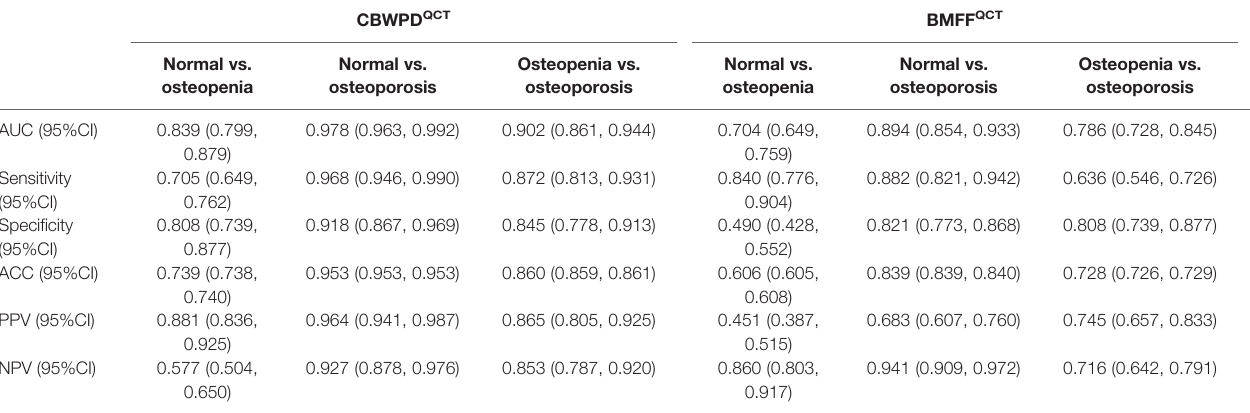
TABLE 2 | Performance of the CBWPD QCT and BMFF QCT in discrimination between three cohorts of normal subjects, patients with osteopenia, and patients with osteoporosis, with QCT as reference standard. CBWPD QCT BMFF QCT Normal vs. Normal vs. Osteopenia vs. Normal vs. Normal vs. Osteopenia vs. osteopenia osteoporosis osteoporosis osteopenia osteoporosis